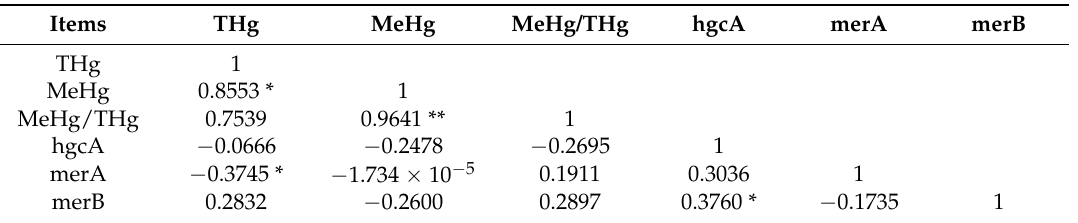
Table 4. Correlations between THg, MeHg, MeHg/THg, hgcA, merA and